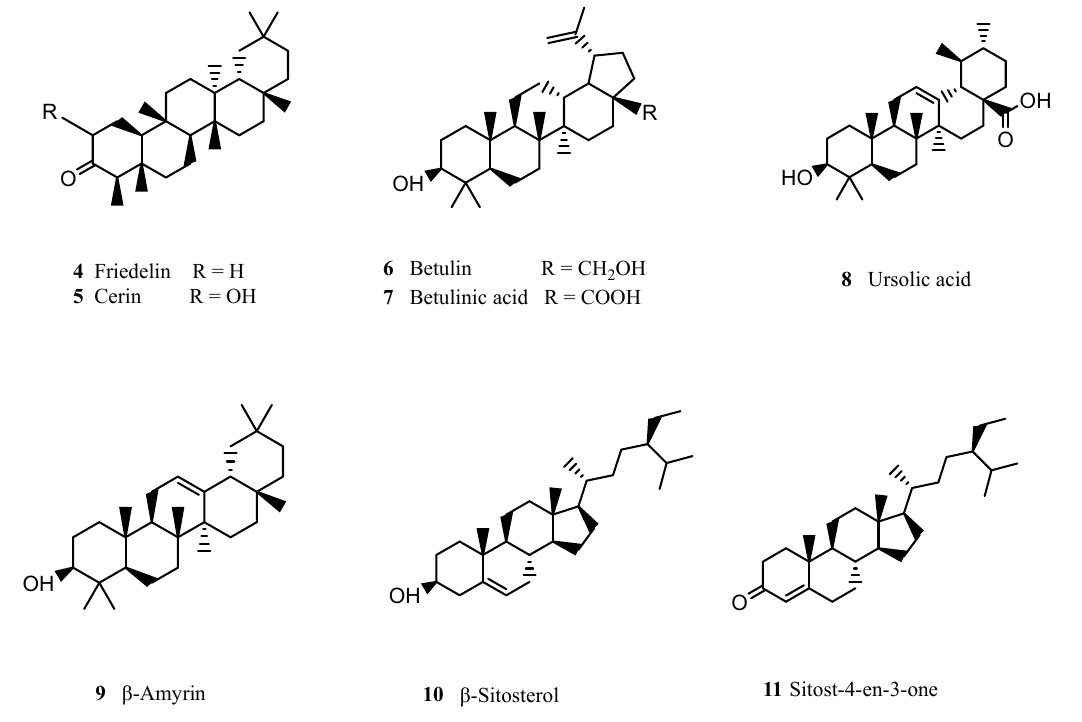
Figure 3. Chemical structures of the main triterpenoids identified in cork.